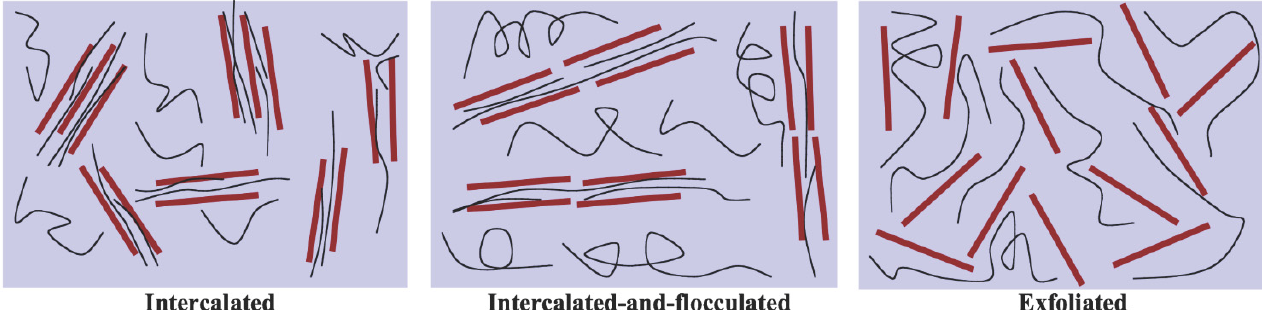
Figure 4. Schematic illustration of three different types of thermodynamically achievable polymer– layered silicate nanocomposites. Reproduced with permission from [1]. © 2003, Elsevier Ltd. Table 1. Advantages/disadvantages of polymer nanocomposites.